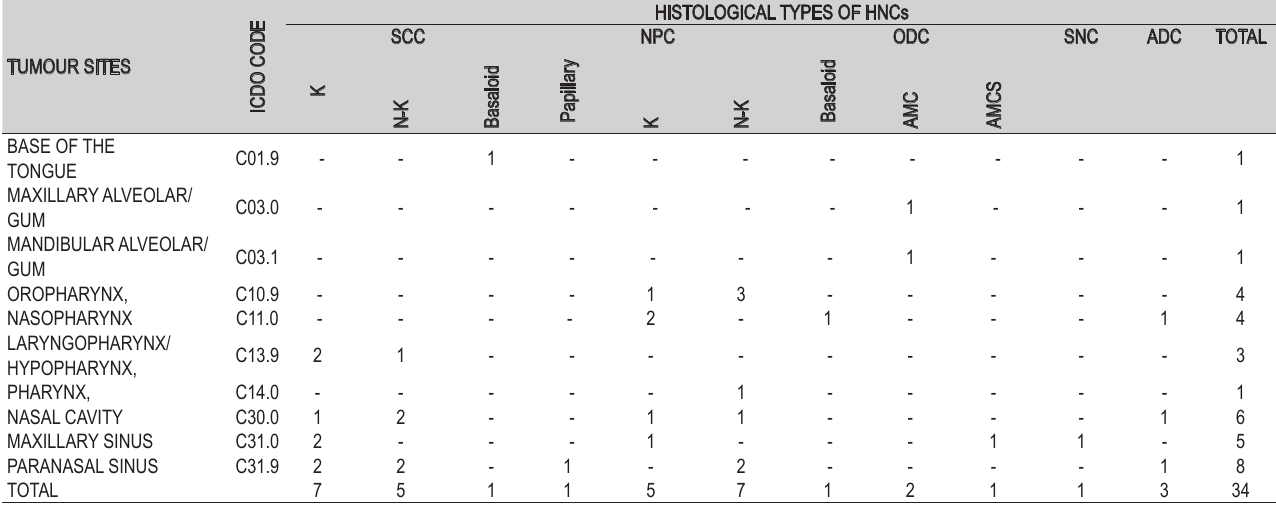
Table 1 - Site distribution of HNCs according to histological